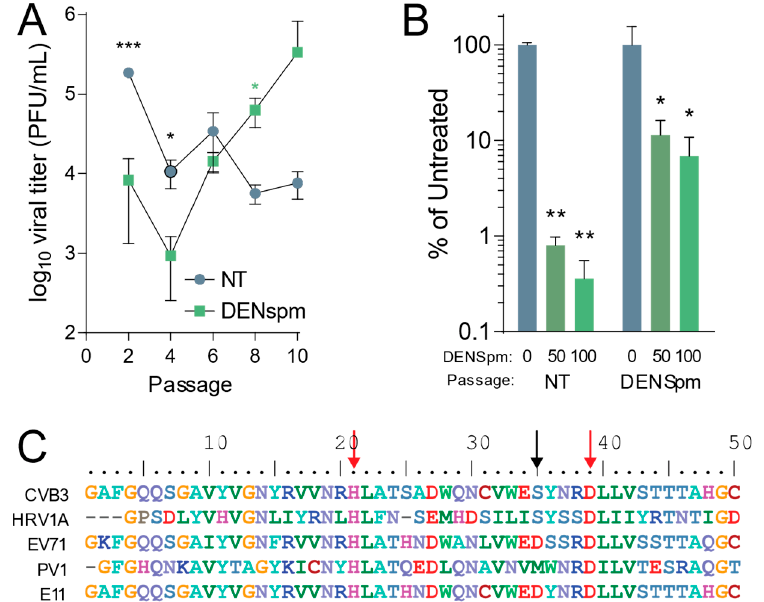
Figure 2. Coxsackievirus B3 gains resistance to DENSpm via mutation in 2A protease. ( A ) Vero-E6 cells were left untreated or treated with 100 μ M DENSpm for 16 hours prior to infection with CVB3 at an MOI 0.1. Virus was collected at 24 hpi and used to inoculate the next passage. Viral titers were determined via plaque assay for the passages shown. ( B ) CVB3 passaged 10 times over Vero-E6 cells, either treated with 100 μ M or untreated, were used to infect Vero cells treated with increasing doses of DENspm for 24 hpi. Viral titers were determined by plaque assay. ( C ) Partial 2A protease sequence of CVB3 compared to other enteroviruses. Red arrows indicate amino acid residues of the protease active site, and the black arrow indicates mutated amino acid residue of 2A S35 mutants. * p ≤ 0.05, ** p ≤ 0.01, *** p ≤ 0.001 using Student’s t -test ( n ≥ 3), comparing treated samples to untreated controls. Error bars represent ± 1 SEM.